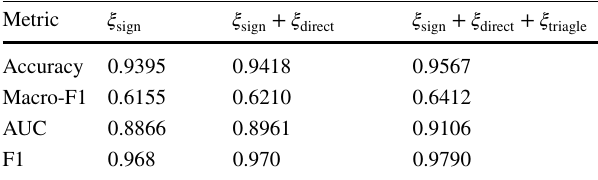
Table 4 Ablation study on loss